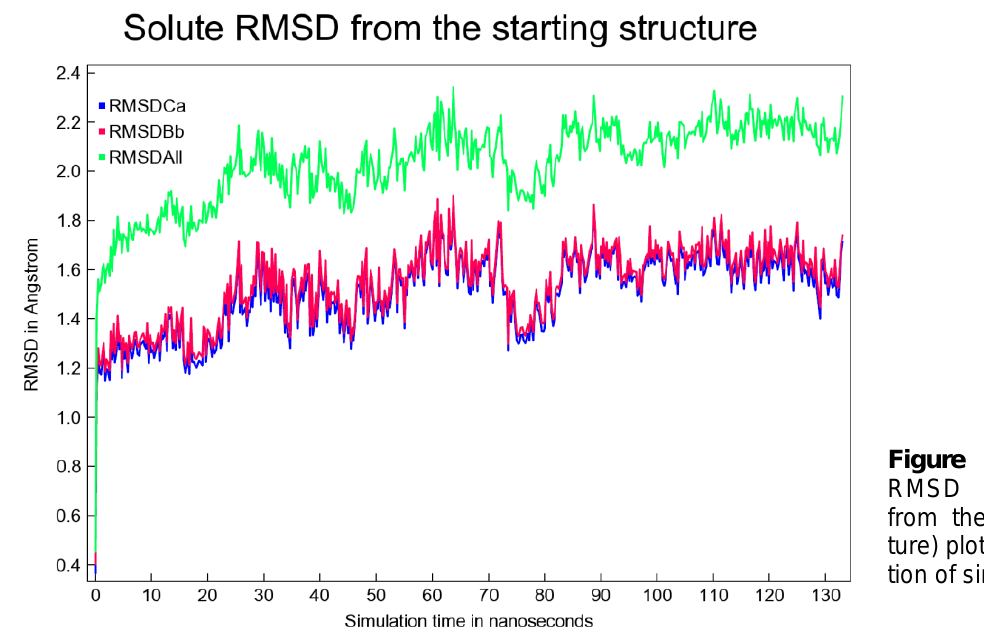
Figure 5: Solute RMSD (measured from the initial struc- ture) plotted as a func- tion of simulation